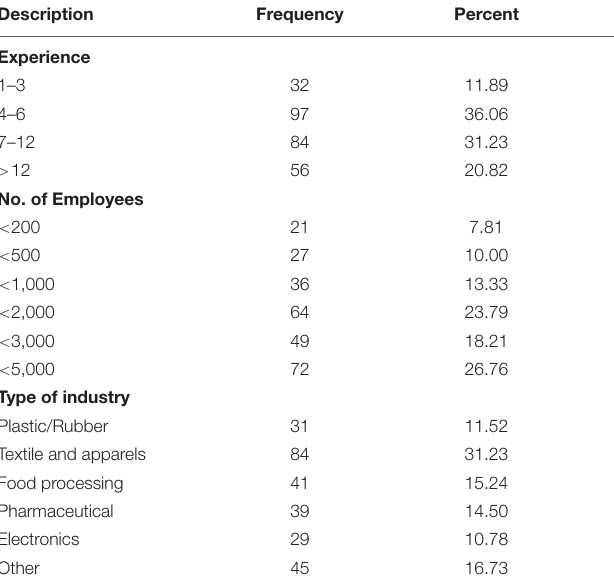
TABLE 1 | Demographic profile of